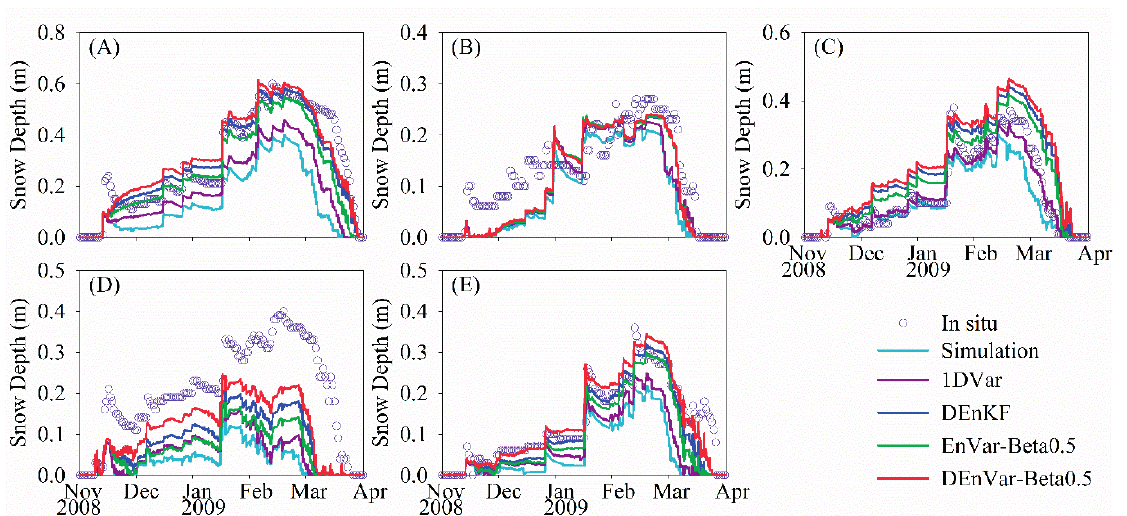
Figure 3. Comparison of SD time series from in situ observations and the assimilated results from different DA experiments at the ( A ) Aletai, ( B ) Buerjin, ( C ) Fuyun, ( D ) Jimunai, and ( E ) Qinghe